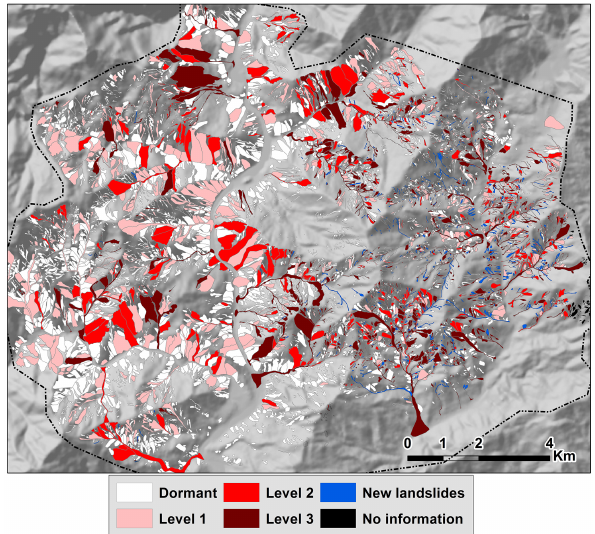
Figure 8. Landslide inventory map based on the image taken in April 2011, reflecting the state of activity after the rainy seasons of 2009 and 2010.